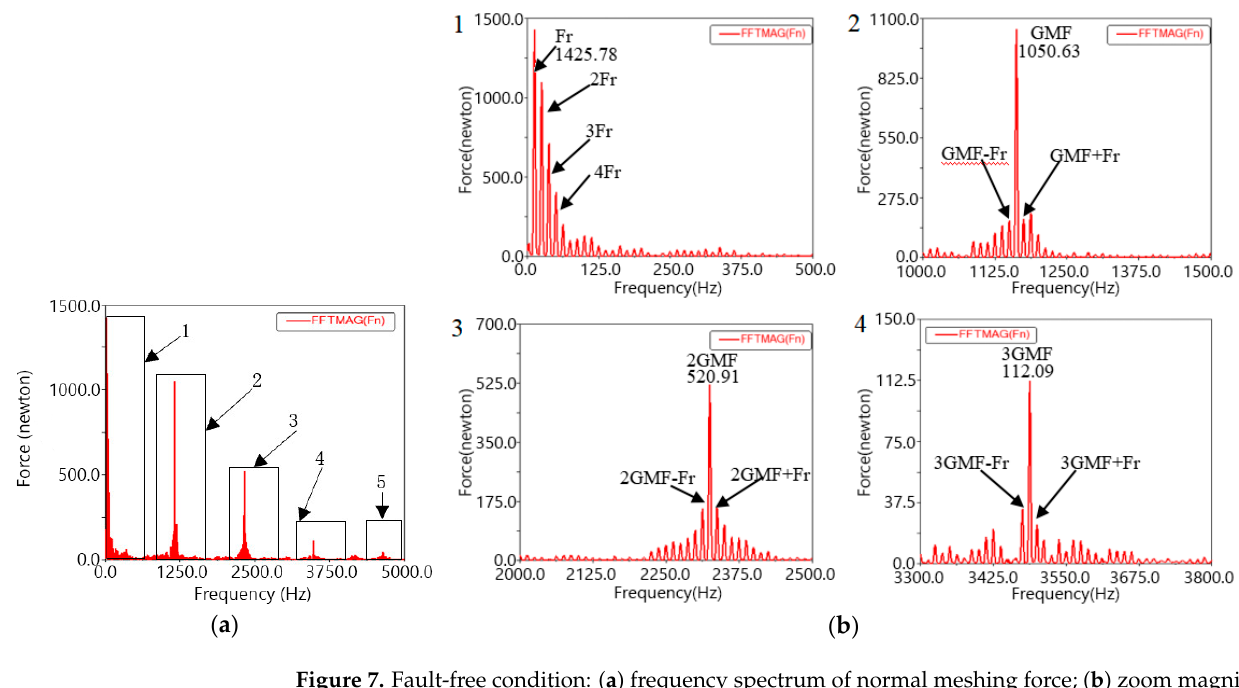
Figure 7. Fault-free condition: ( a ) frequency spectrum of normal meshing force; ( b ) zoom magnified